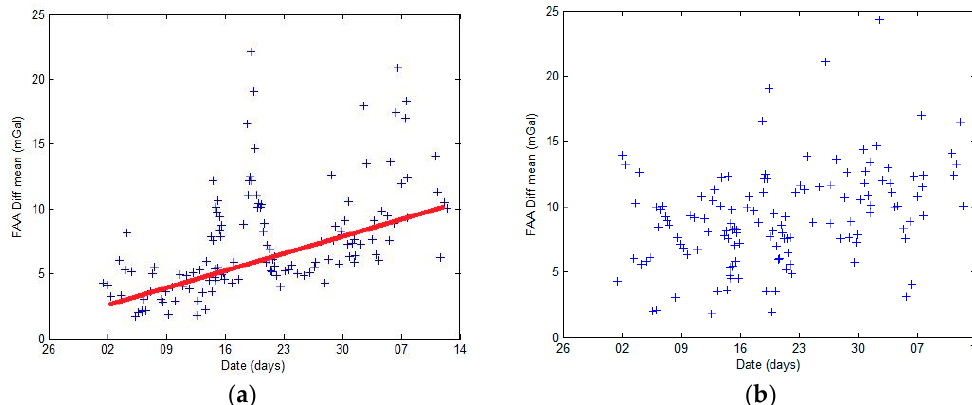
Figure 7. ( a ) Profile average difference before difference adjustment; ( b ) Profile average difference after difference adjustment.